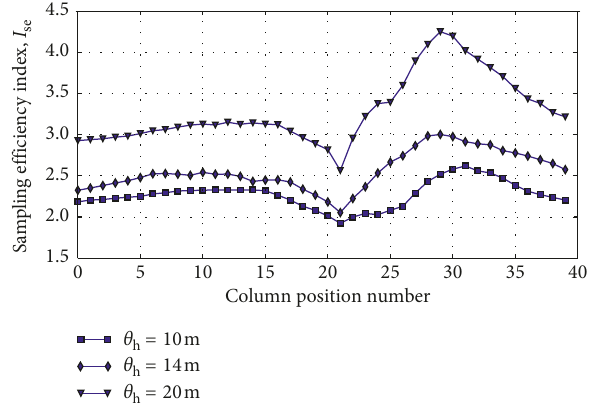
Figure 13: Sampling efficiency indices at different sampling lo- cations for various values of θ (2 CPT sampling, 1st CPT fixed at h i � 21), example